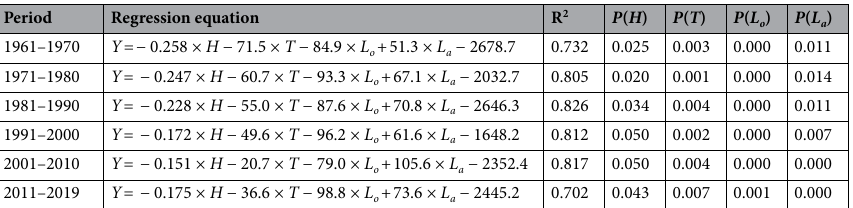
Table 4. Regression equation of geographical factors (altitude ( H ), temperature ( T ), longitude ( L o ) and latitude ( L a )) and annual precipitation of meteorological stations in different periods. Regarding P ( H ), P ( T ), P ( L o ) and P ( L a ) means the result of t test, less than 0.05 indicates that the variable is